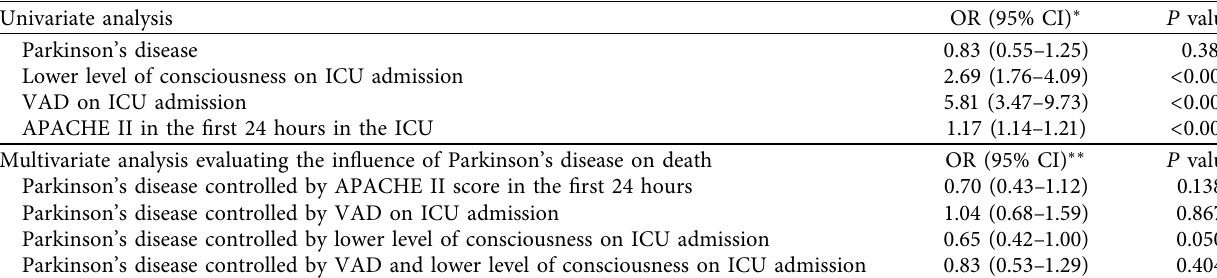
Table 2: Univariate and multivariate analysis using death as a dependent